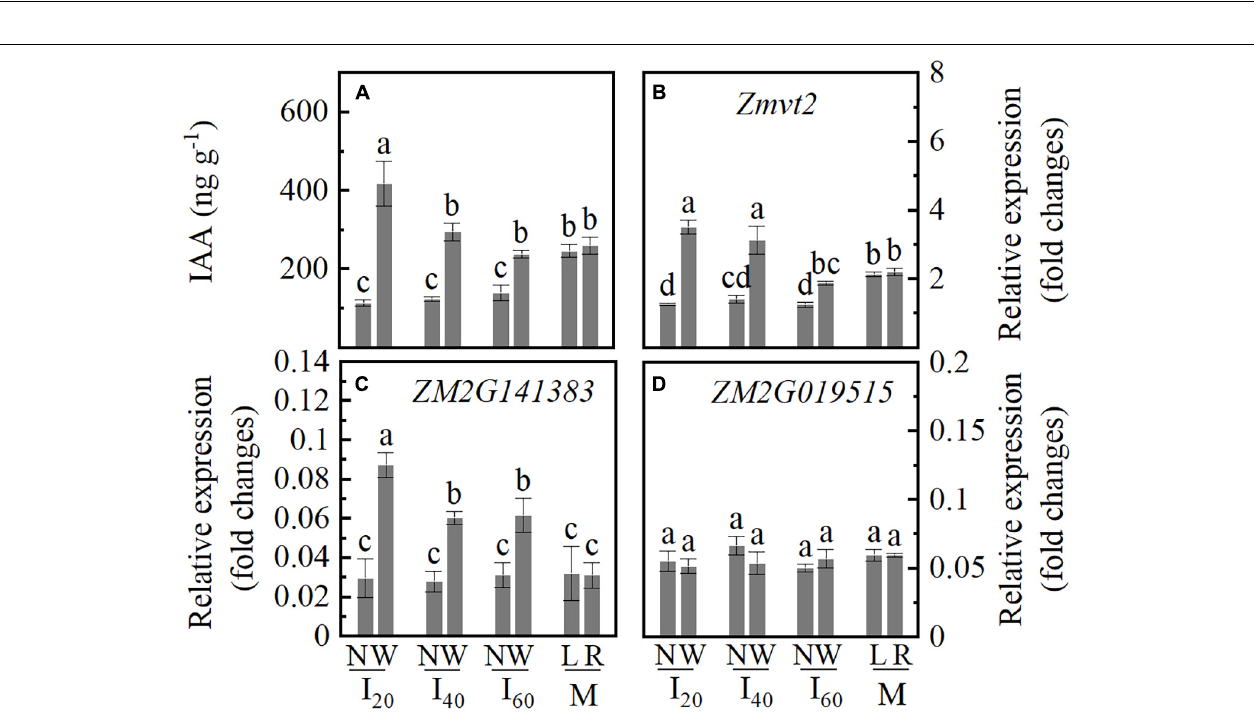
FIGURE 6 | Indole-3-acetic acid (IAA) concentration, relative expression levels of the key genes of IAA biosynthesis in Study 1 (2020). I 20 , I 40 , and I 60 represent the intercropping maize planted in narrow–wide row spacing patterns, narrow and wide row spacing of 20 + 200, 40 + 180, and 60 + 160 cm, respectively. M: monoculture maize with a row spacing of 70 cm. ML: the left side of monoculture plant; MR: the right side of monoculture plant. N: stem nodes (the first node of aboveground) of narrow row at stage V14; W: stem nodes (the first node of aboveground) of wide row at stage V14. Data with the different letters are significantly different ( p < 0.05). (A) Indole-3-acetic acid (IAA) concentration. (B–D) The relative expression levels of Zmvt2, ZM2G141383, and ZM2G01951, respectively.